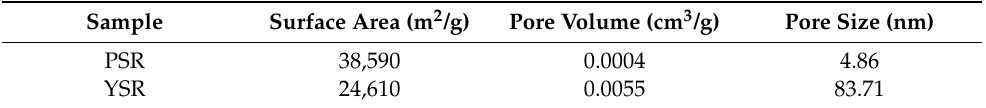
Table 4. Surface area and porosity analysis of